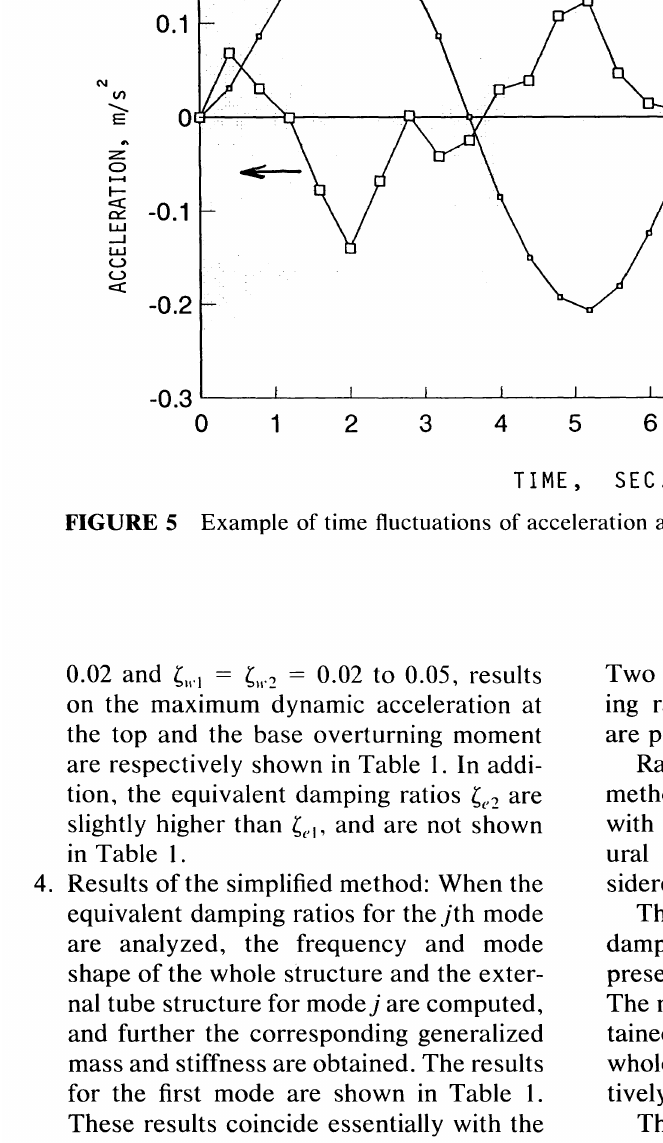
FIGURE 5 Example of time fluctuations of acceleration at top floor and base overturning moment.